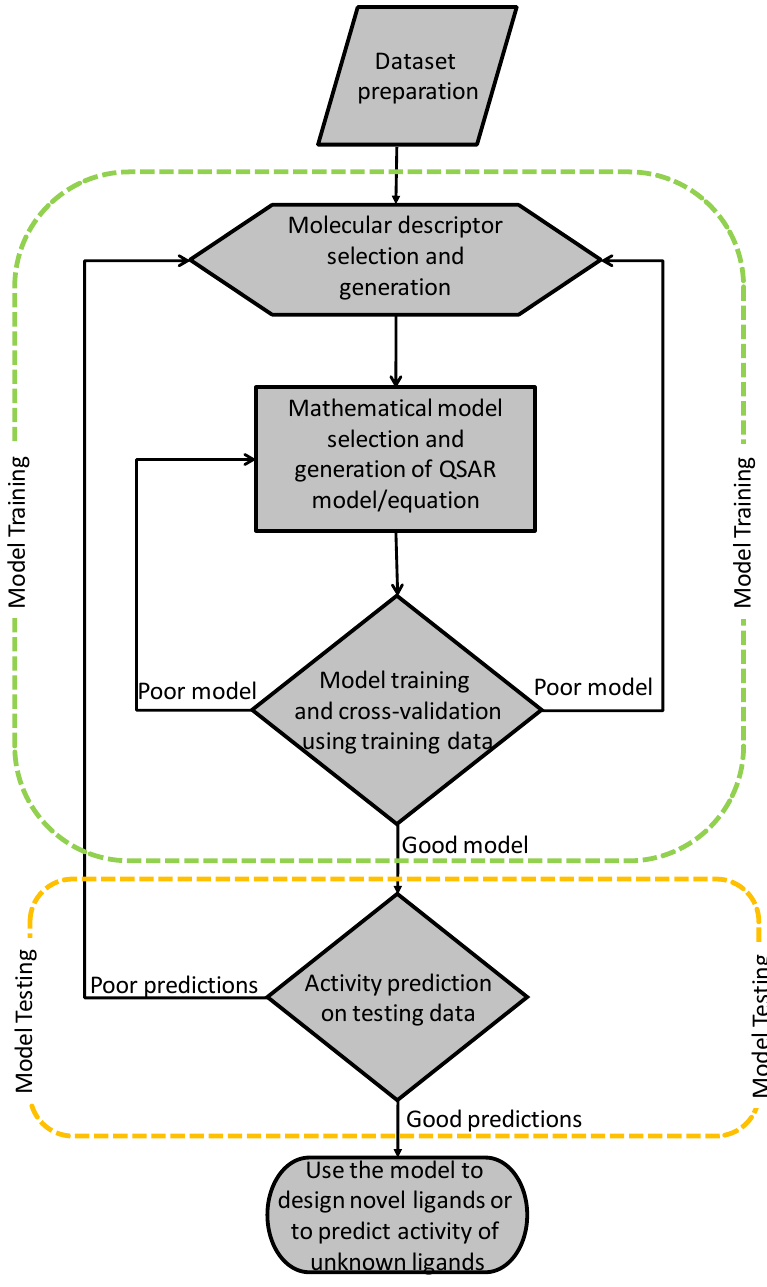
Figure 1. A general scheme of a QSAR model development which includes systematic training and testing